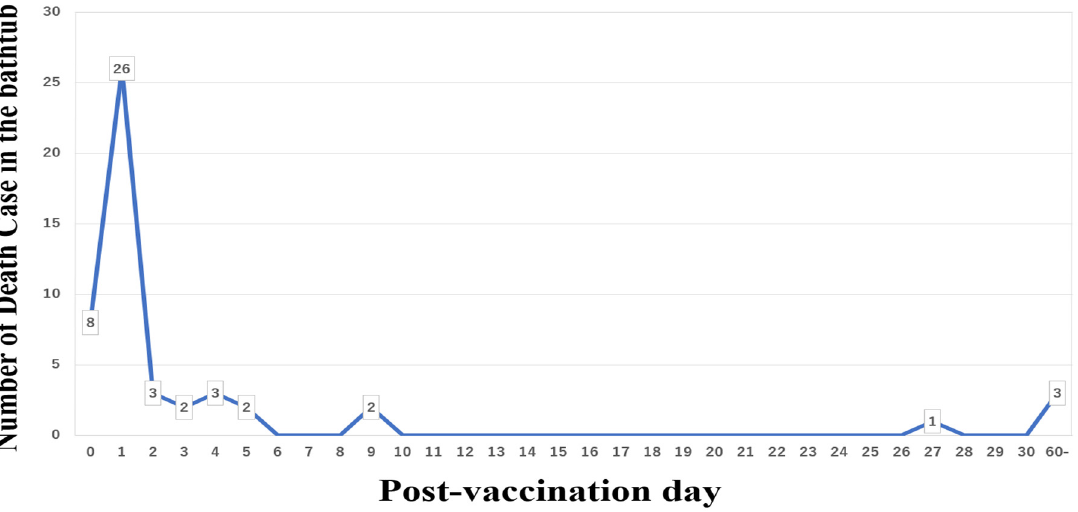
Figure 1. Deaths while sitting in the bathtub after COVID-19 mRNA vaccination.